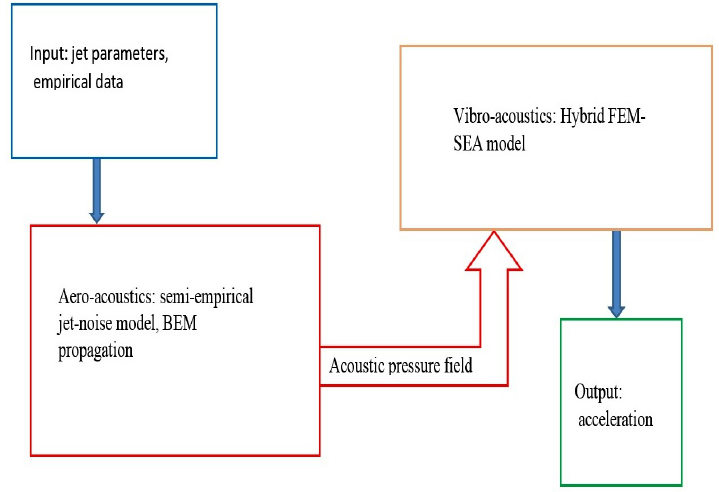
Figure 1. ThelogicalschemeoftheintegratedmultidisciplinaryapproachusedfortheVEGAConsolidation and Evolution Program (VECEP) design verification process, described in this paper, is